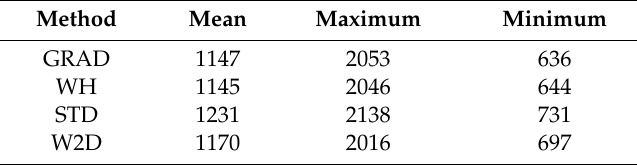
Table 4. Comparison of the ML height (m) determined by di ff erent methods for summer sunny days of 2013.